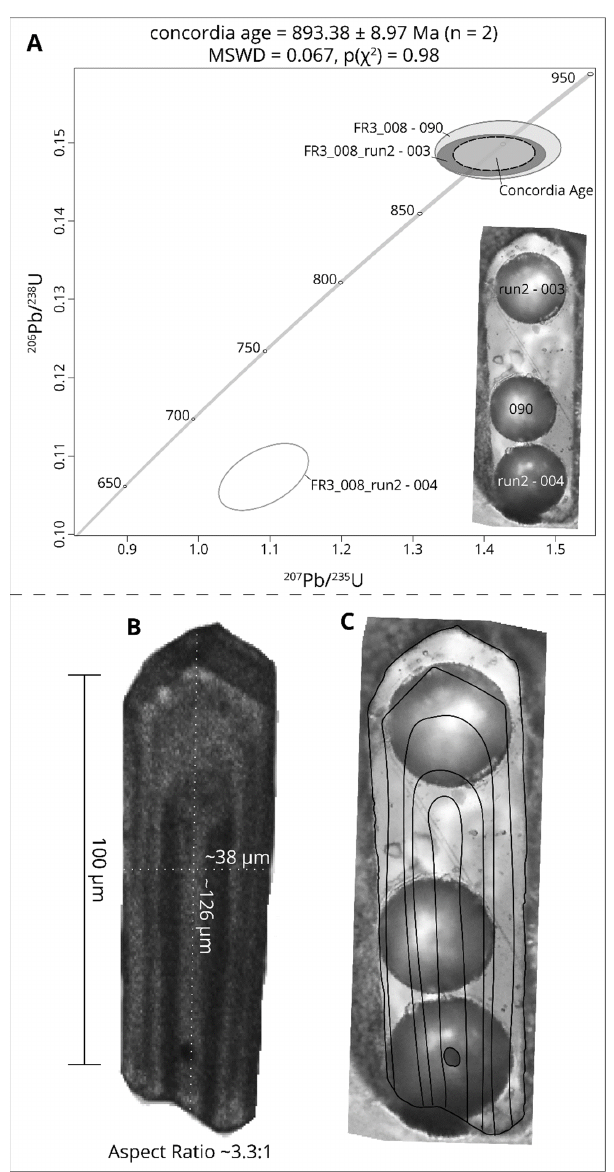
Figure 6. ( A ) Concordia plot and age of the three spots analysed on the youngest single zircon for FR3_008 (Shanahan Conglomerate Member). Spots are labelled on the reflected light image. ( B ) Cathodoluminescence image overlain with measurements for aspect ratio. ( C ) Outlines of growth zones and inclusion overlain on reflected light image. Concordia plot generated using IsoplotR [69].